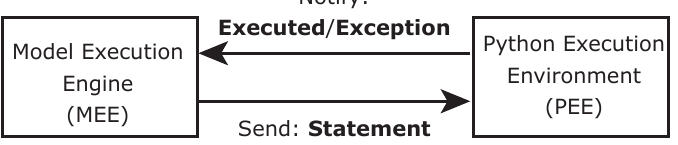
Figure 5. The framework